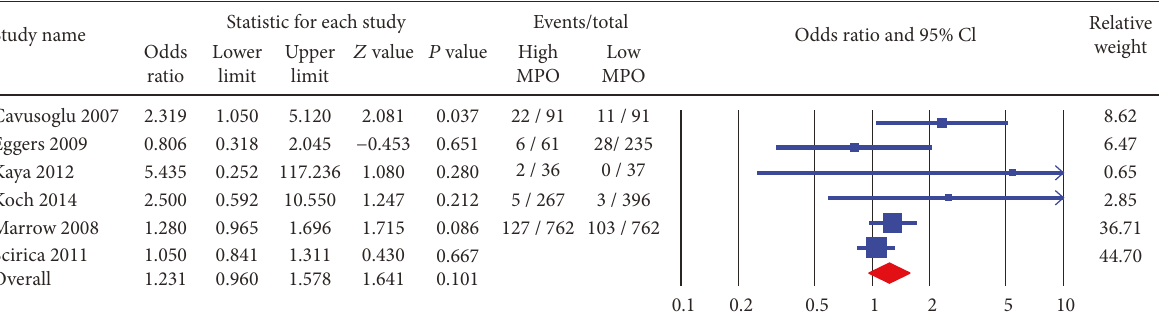
Figure 4: Forest plot for recurrent myocardial infraction (MI). High myeloperoxidase showed a trend towards higher risk of recurrent MI (odds ratio 1.23; CI: 0.96-1.57, P = 0 101